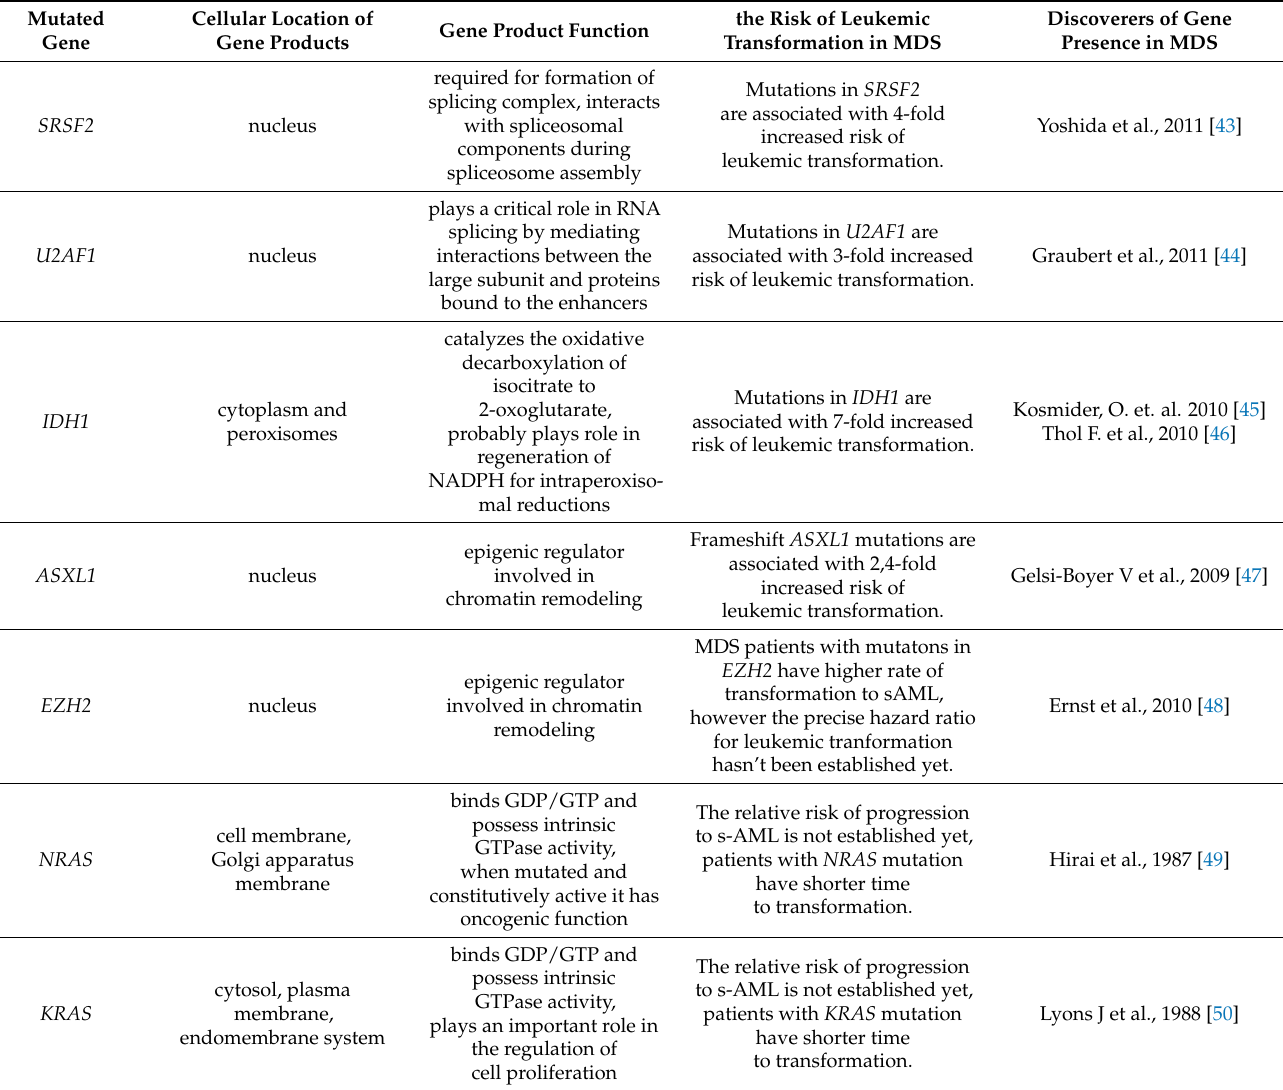
Table 1. The mutations proved to be involved in leukemic transformation in patients with myelodys- plastic syndrome (MDS)